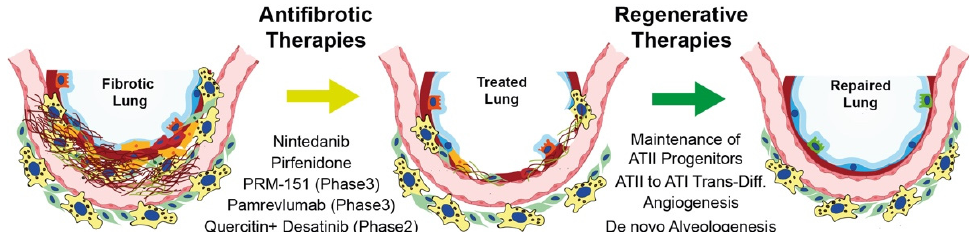
Figure 4. Novel therapeutic strategies for IPF treatment. Summary illustration of putative strategies to (1) stop fibrosis progression by hampering aberrant ECM deposition and eliminating defective cells (antifibrotic and senolytic drugs) and (2) bring back the lung to a healthy condition by promoting alveolar regeneration (regenerative therapies).